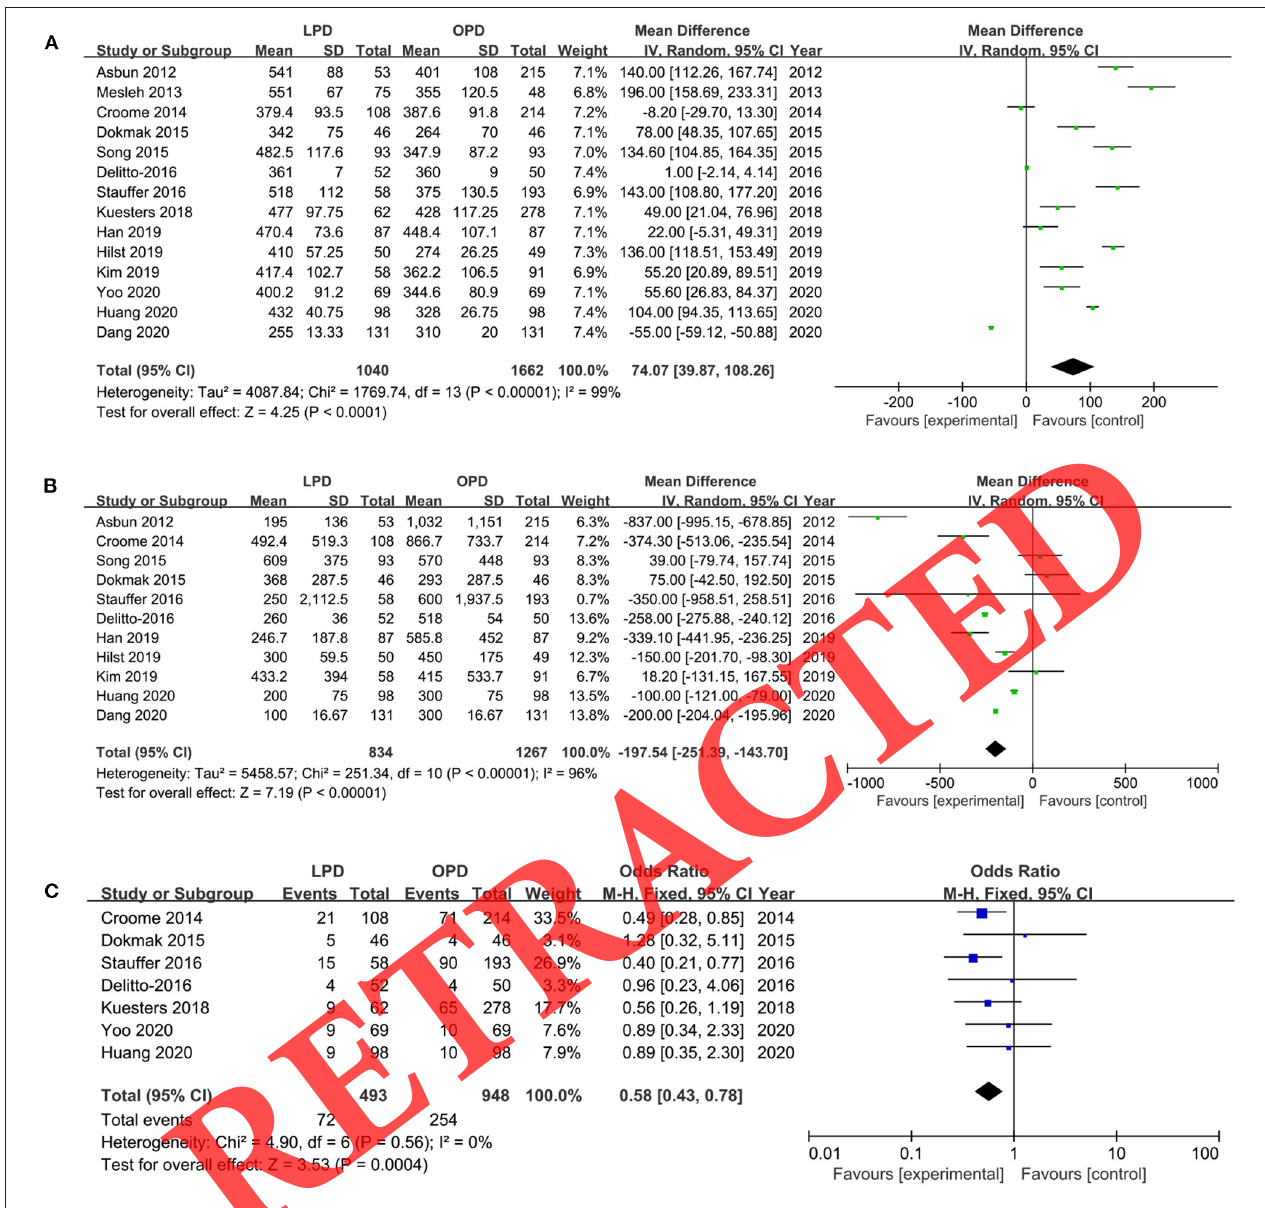
FIGURE 3 | Forest plot of comparison of LPD vs. OPD for operative outcomes. (A) Forest plot for the length of stay; (B) forest plot for blood loss; and (C) forest plot for blood